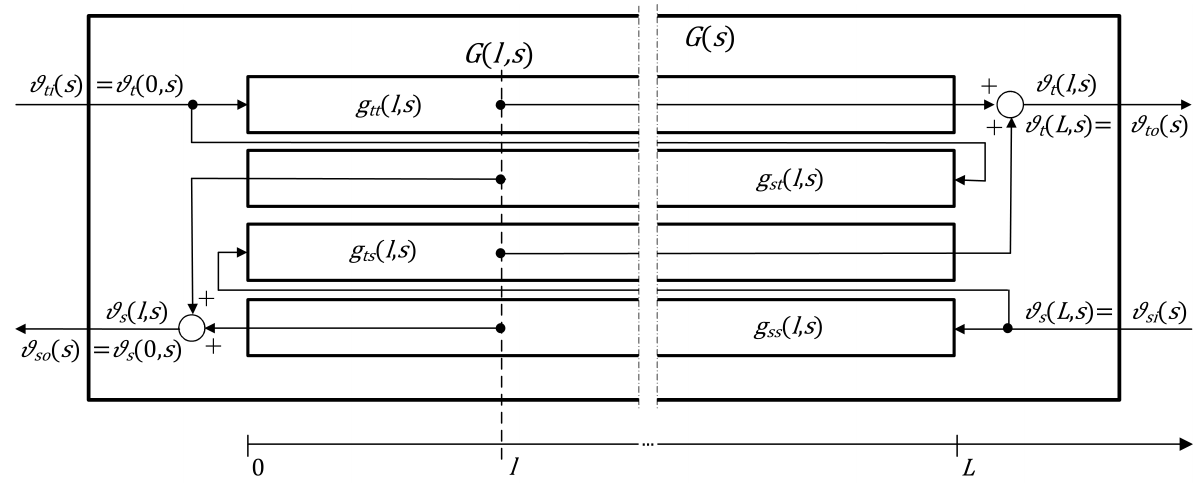
Figure 2. Spatially distributed transfer function model for the double-pipe counter-flow heat